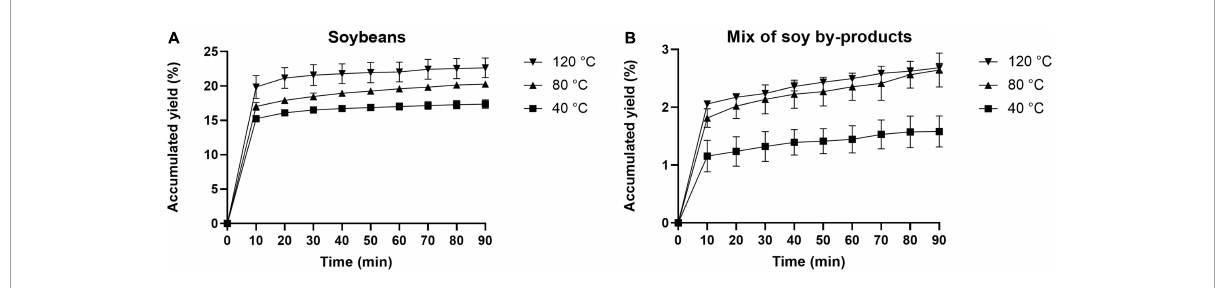
FIGURE2 Kinetic curves based on the yields of soybean and mix of soy by-products extracts generated by PLE using n -heptane at three different temperatures (40, 80, and 120 ◦ C).